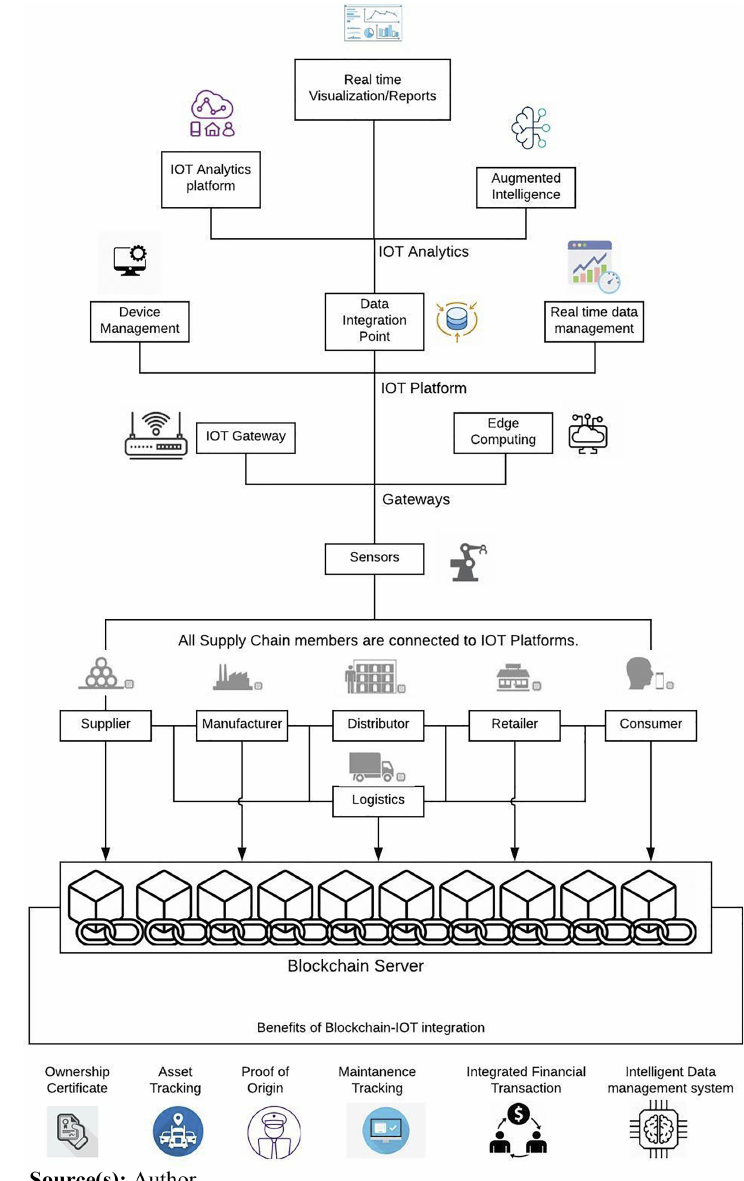
Figure 3. Blockchain